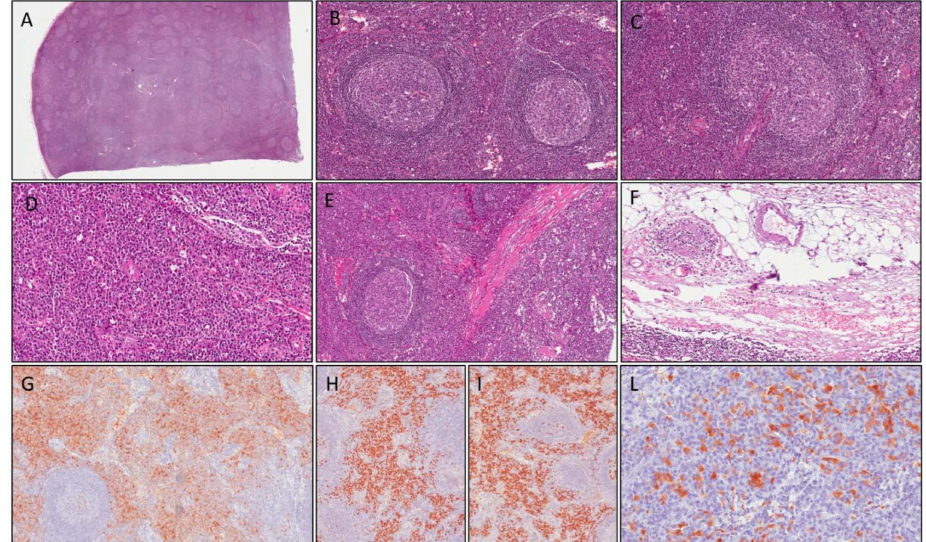
Figure 2. Case 2: histological examination shows follicular hyperplasia ( A ); thickened mantle zones with lymphocytes arranged in layers—an onion skin appearance ( B ); atretic germinal centers traversed by penetrating vessels—lollipop follicles ( C ); numerous polyclonal plasma cells in inter- follicular area ( D ); intranodal fibrous septa ( E ) and aspects of capsular venulitis ( F ). Plasma cells in interfollicular area are stained with CD138 ( G ) and show polyclonal profile (positive for kappa and lambda light chains, respectively, in ( H , I ). Immunoreactivity for IgG4 was positive in >40 plasma cells/HPF ( L